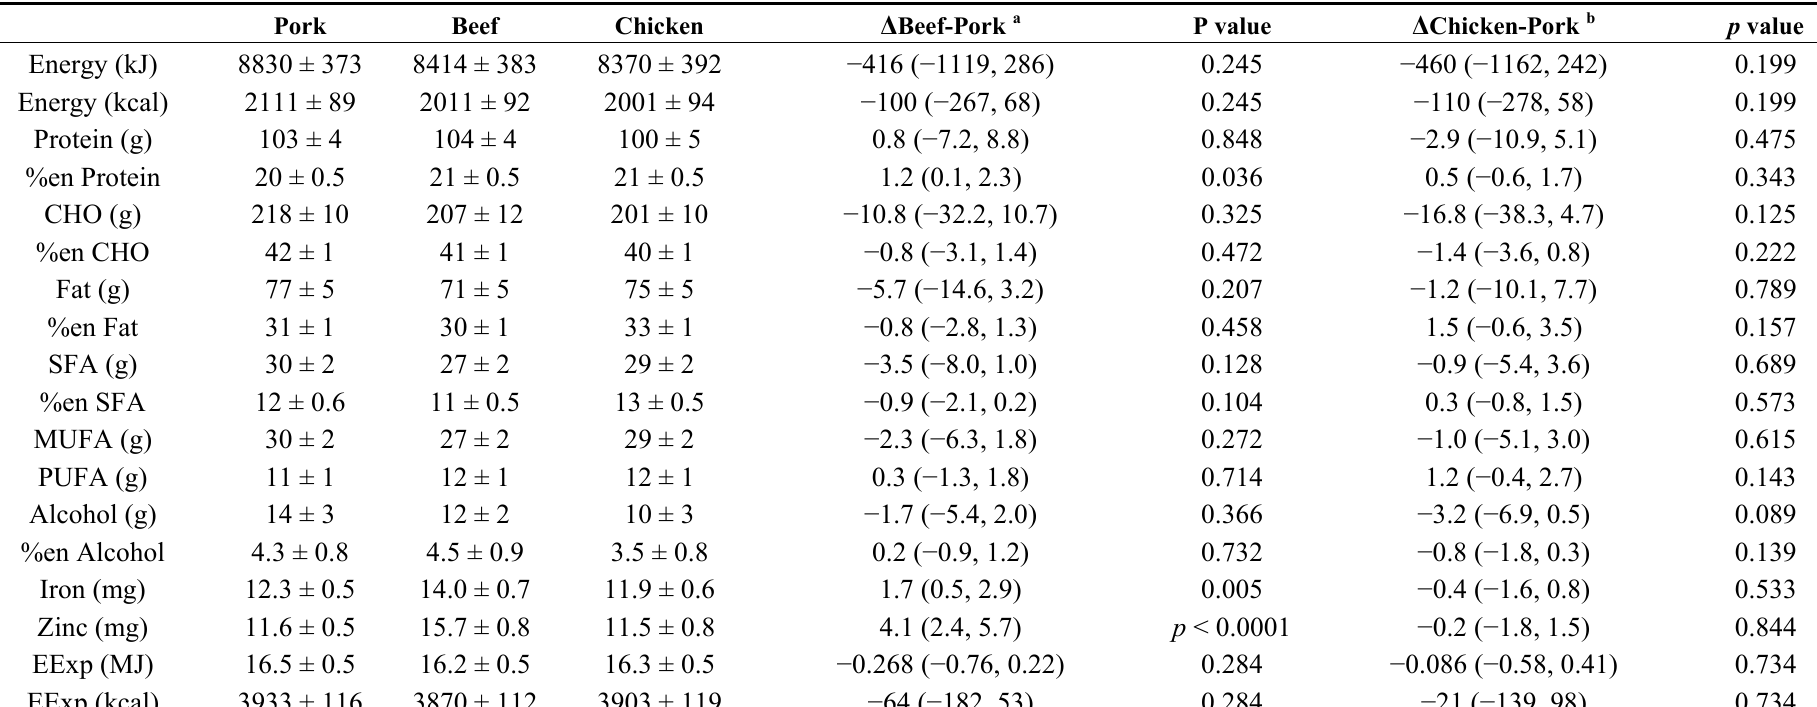
Table 2. Mean values for energy and nutrient intake from weighed food records * at the end of each diet phase (Pork, Beef, Chicken), n = 49 and difference between meats (95% confidence